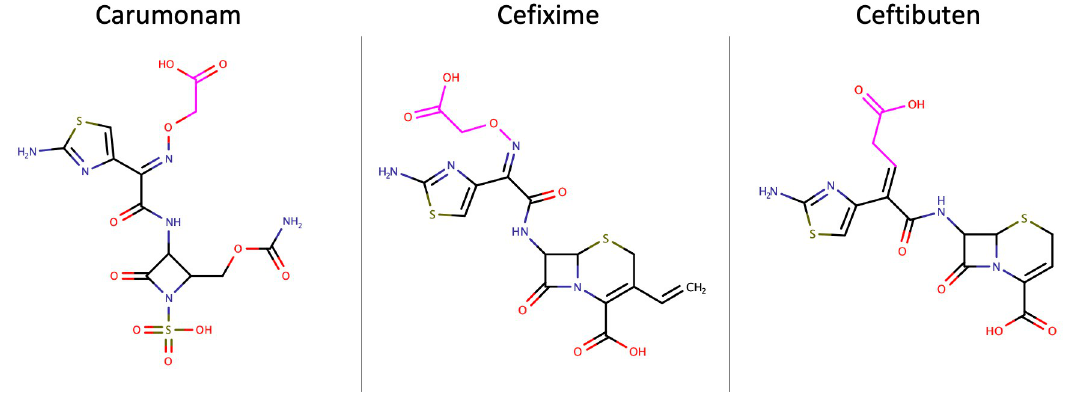
Fig 9. Aligned two-dimensional structural representations of the cephalosporins cefixime and ceftibuten, and of the monobactam carumonam. The negatively charged R-groups that are stabilized by the Arg237 mutation are highlighted in fuchsia.